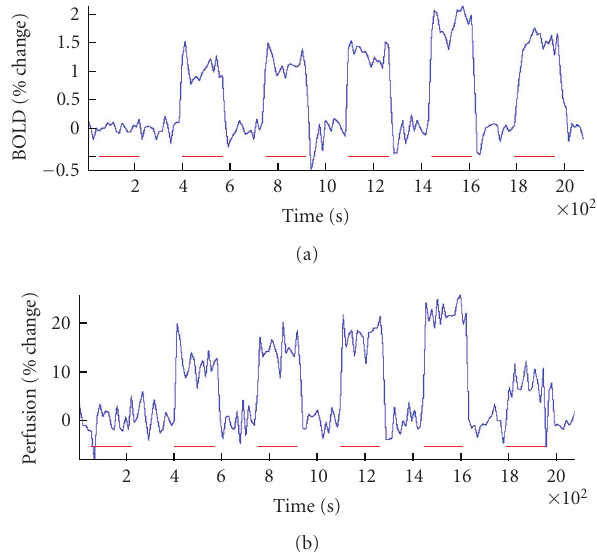
Figure 4: BOLD (a) and FAIR (b) time courses of the CBF percent change in the V1 ROI averaged over 10 subjects are shown, from left to right, corresponding to baseline, 25%, 50%, 75%, and 100% intensity checkerboards and 5% hypercapnia. The horizontal bars represent the 3-minute periods during which the stimulus was on. An increase in signal change can be observed with increasing checkerboard intensity for BOLD and FAIR perfusion, ranging between 1.0%–1.9% and 11.4%–22.5%,